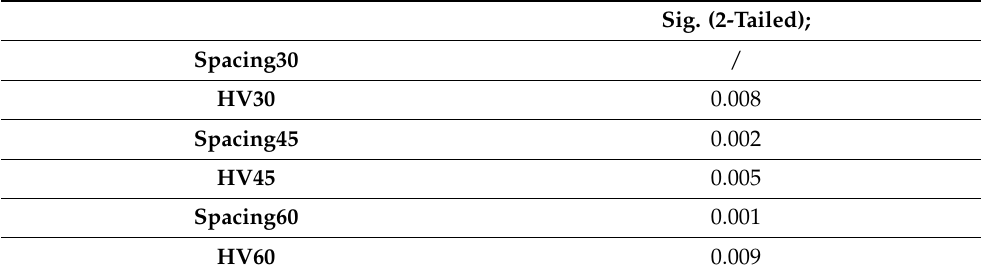
Table 7. The single-sample t -test of MOWOA2.